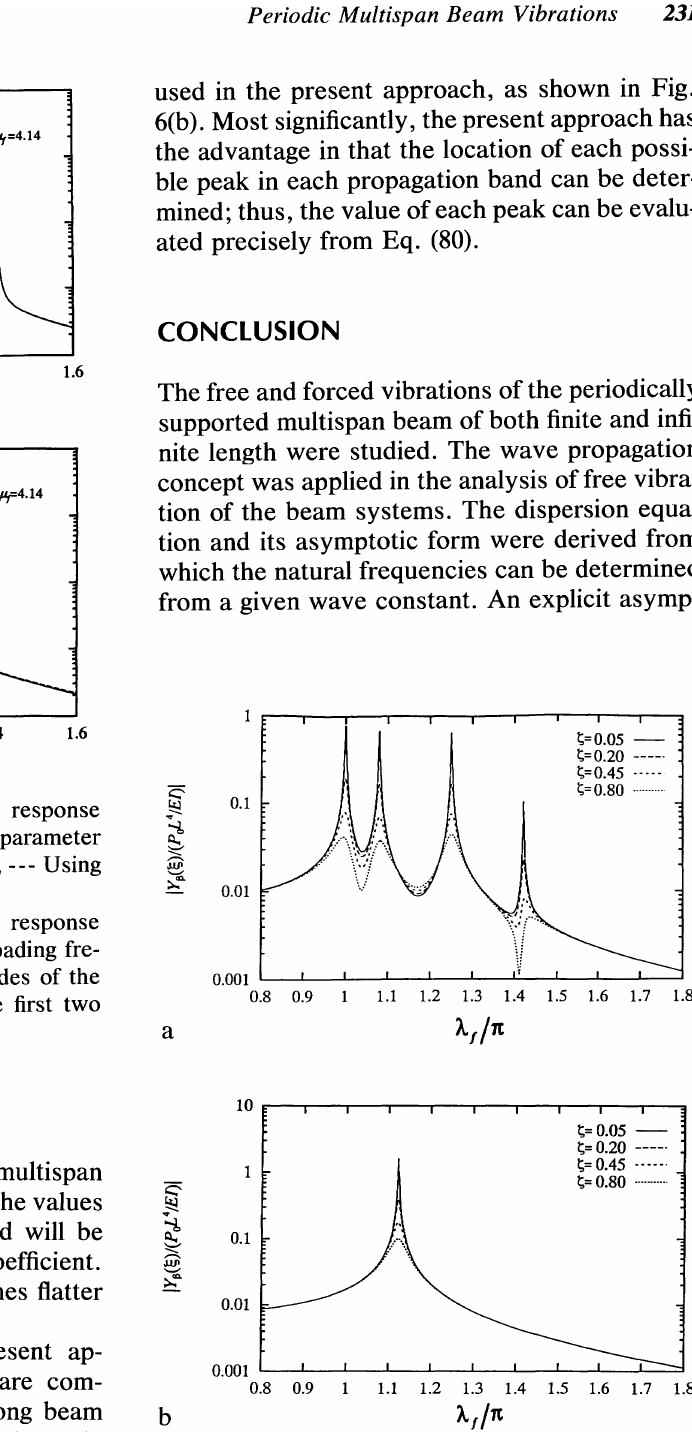
FIGURE 5(a) Nondimensional harmonic response of a four-span beam vs loading frequency parameter AI with different damping coefficients (f3 = 2, { = 0.5, ILl = 4.14). FIGURE 5(b) Nondimensional harmonic response of an infinite long multi-span beam vs loading fre quency parameter AI with different damping coeffi cients (f3 = 2, { = 0.5, J.tJ =